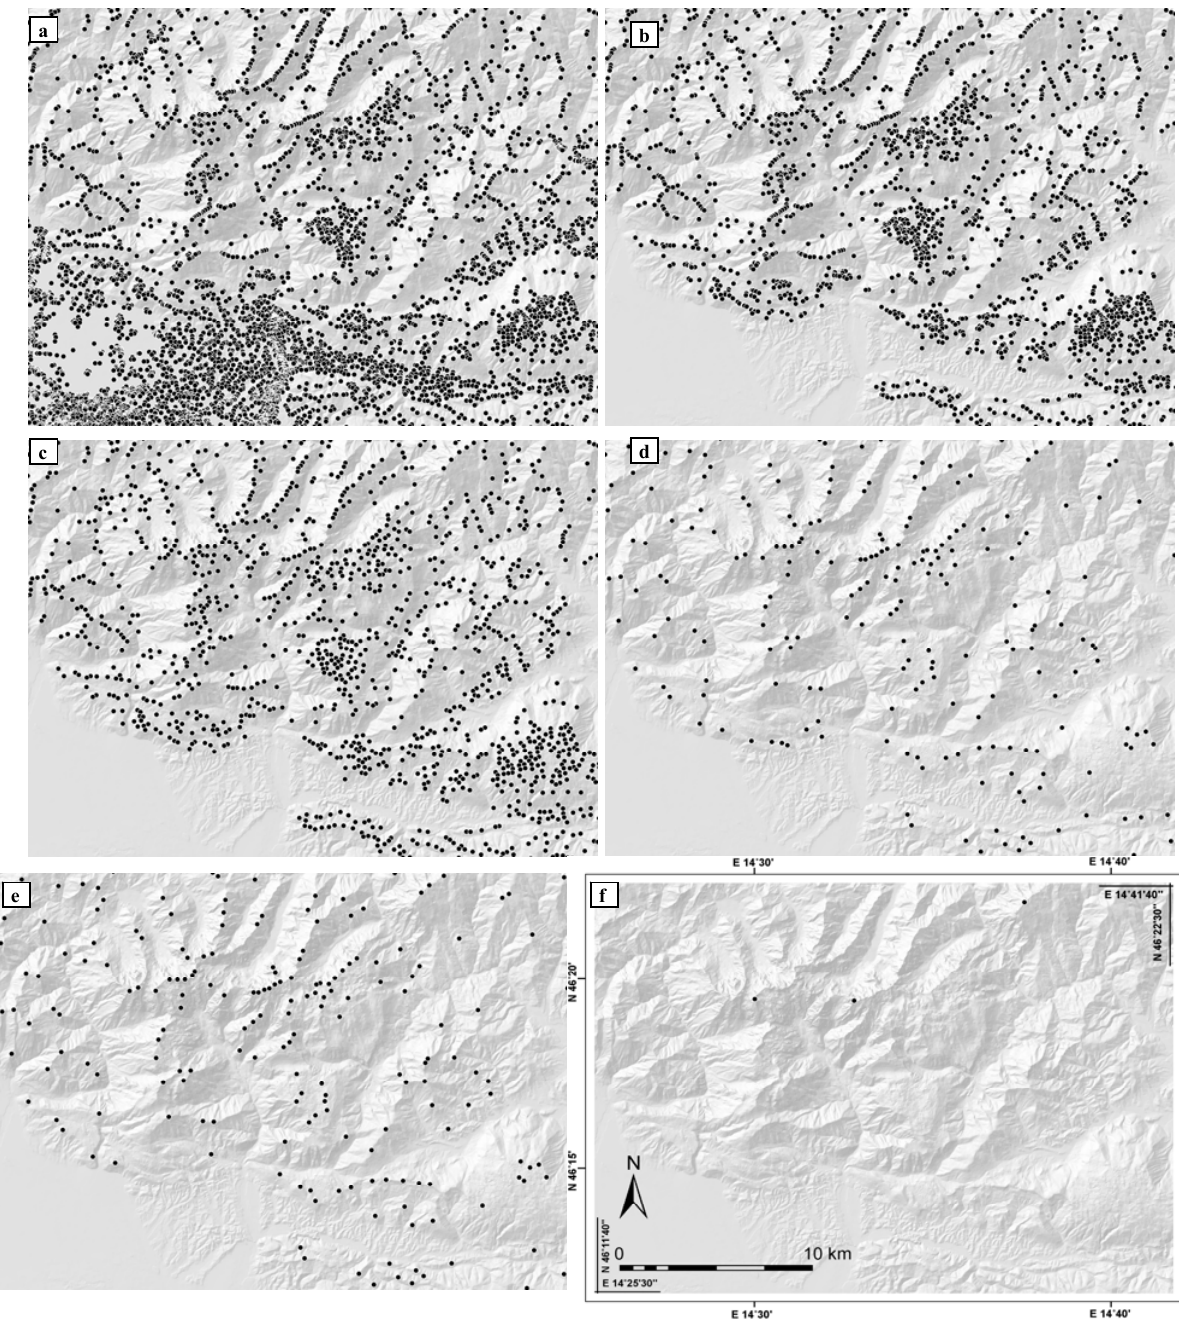
Figure 3. The detection (identification) of the regional peaks (black dots) according to the five-step procedure. Picture ( f ) presents an additional attempt at detecting global